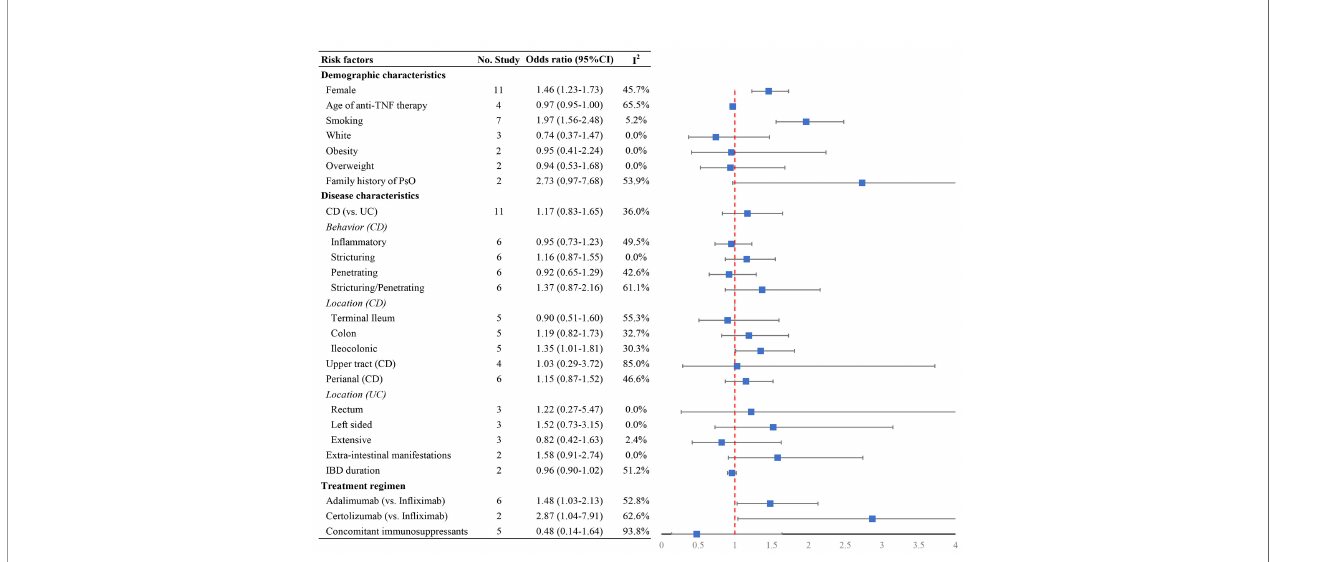
FIGURE 4 | Forest plots of the odds ratio for the risk of developing psoriasiform lesions and/or psoriasis in in fl ammatory bowel disease patients receiving anti-tumor necrosis factor therapy.